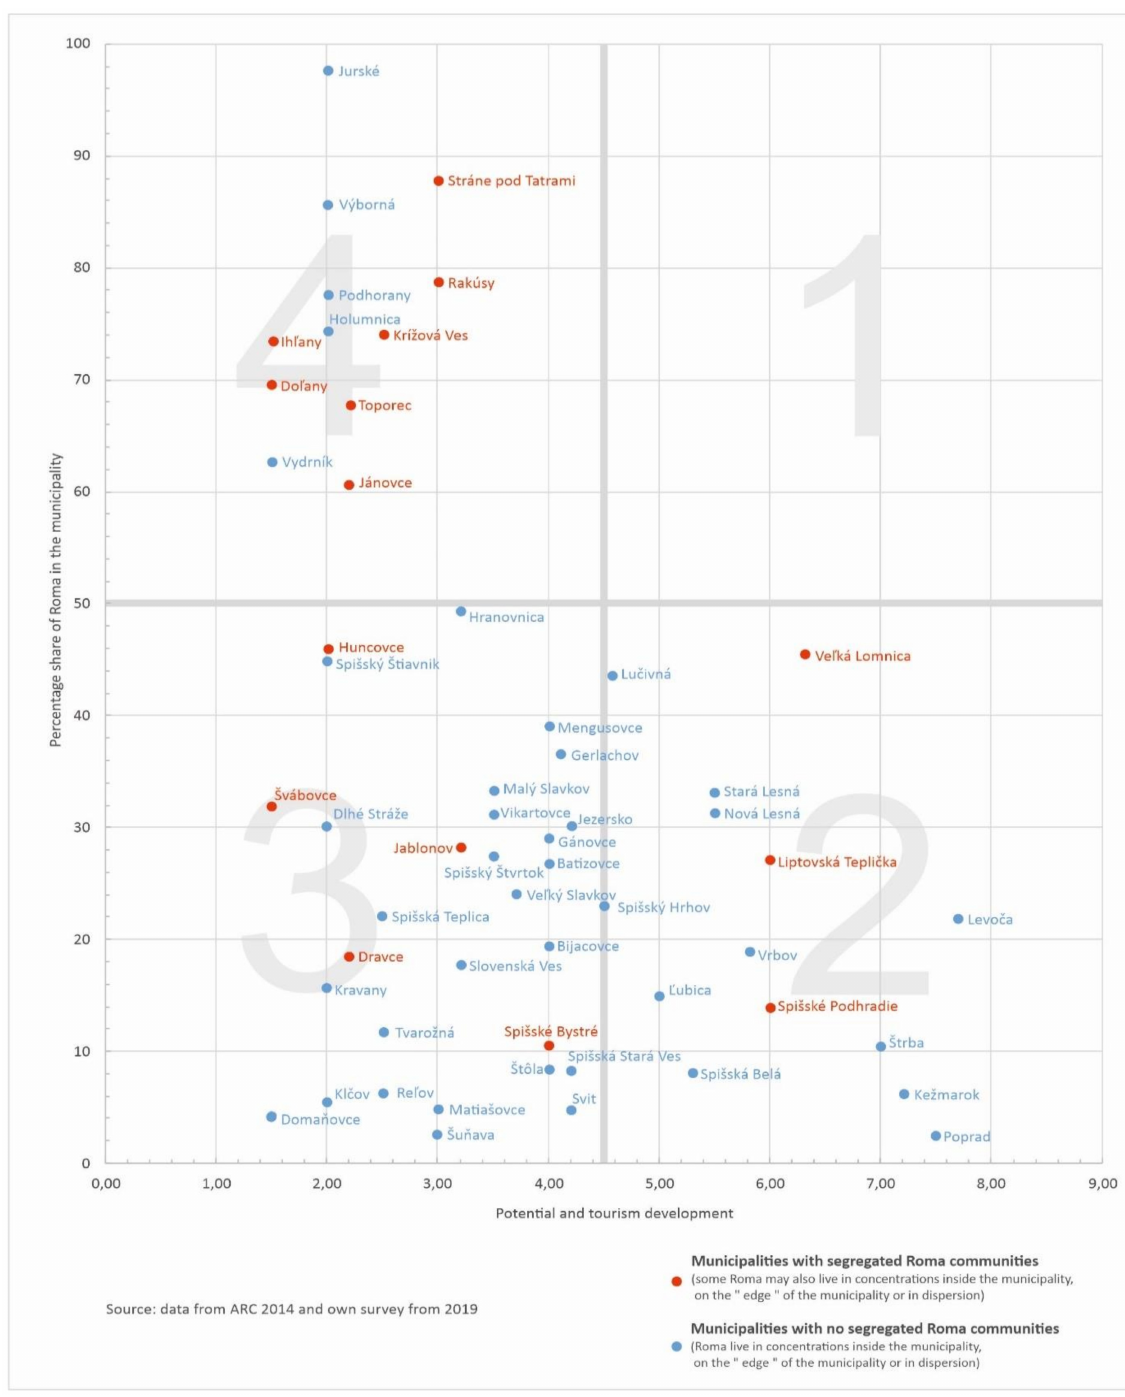
Figure 2. Attractiveness and development of tourism in municipalities with MRCs of Central Spiš. Source: own evaluation based [45,47] for more see